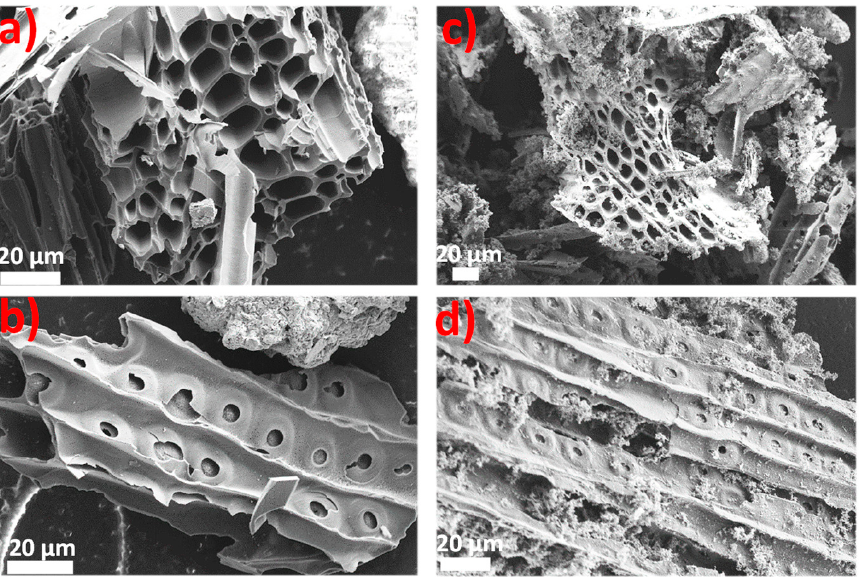
Figure 2. SEM images of biochar before and after the modification as BC-nZVI: ( a ) Sharp edges of biochar with high porosity; ( b ) Smooth surface of biochar with macropores; ( c ) Iron (nZVI) particles accumulated in the sharp edges in BC-nZVI; and ( d ) Iron (nZVI) particles distributed on the surface in BC-nZVI.